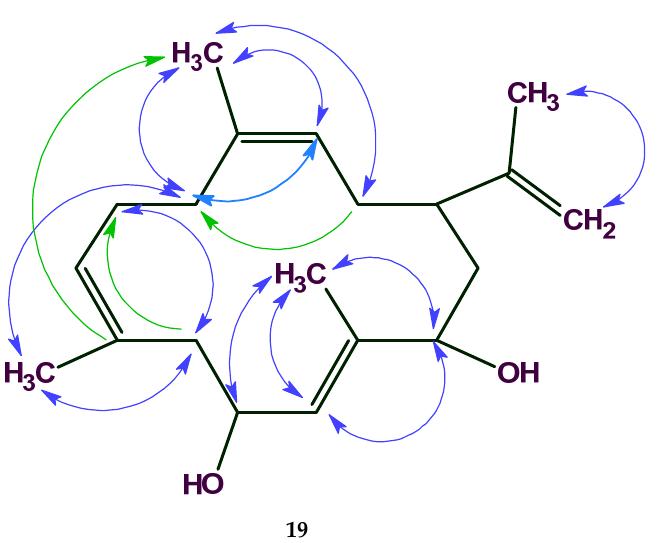
Figure 15. The COSY connectivities are represented on the structure by blue double-headed arrows while the HMBC correlations are defined by green unidirectional arrows from the proton to the carbon to which it is long-range coupled.